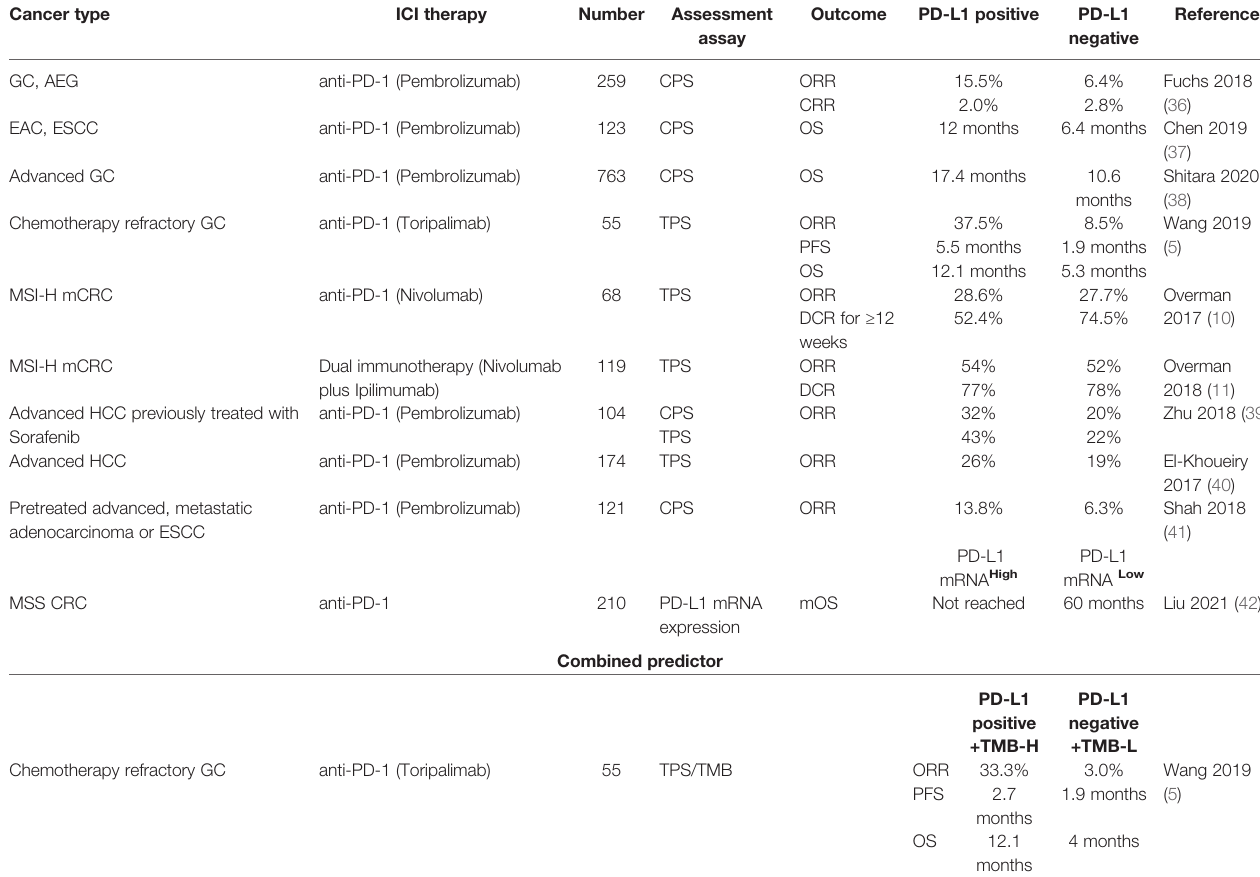
TABLE 2 | Predictive ability of PD-L1 expression for response to ICI therapy for digestive system